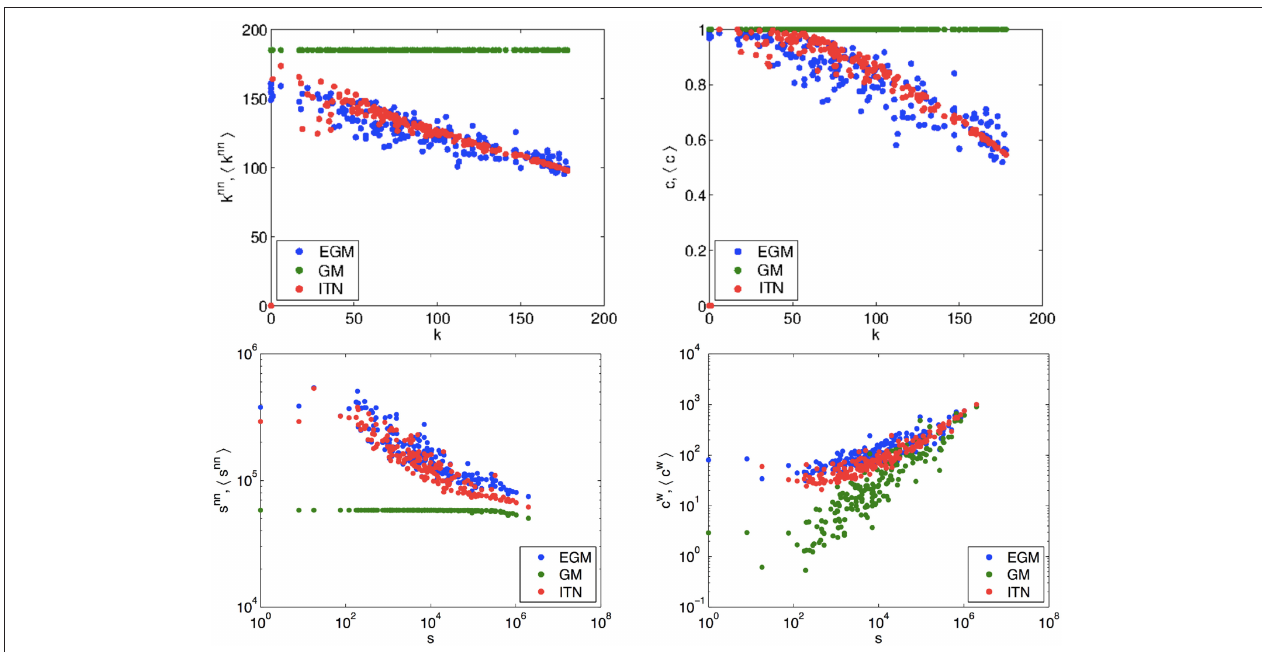
FIGURE 5 | Network properties in the real ITN (red), the GM (green), and the EGM (blue). Top left: average nearest neighbor degree k nn i vs. degree k i for all nodes. Top right: clustering coefficient c i vs. degree k i for all nodes. Bottom left: average nearest neighbor strength s nn i vs. strength s i for all nodes. Bottom right: weighted clustering coefficient c w i vs. strength s i for all nodes. All results are for the snapshot of the ITN in the year 2000. For all the other years in the analyzed sample, we systematically obtained very similar results. See Appendix for information about the data and all definitions of empirical and observed